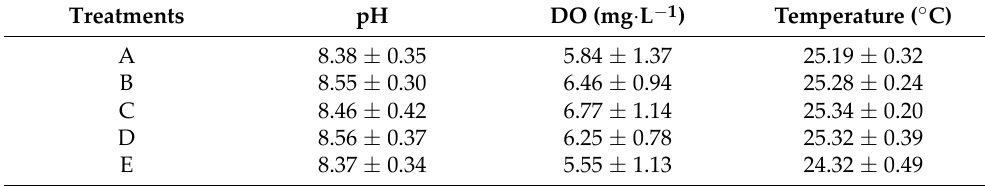
Table 2. Water quality parameters in five treatments throughout the 13‑day experimental period.